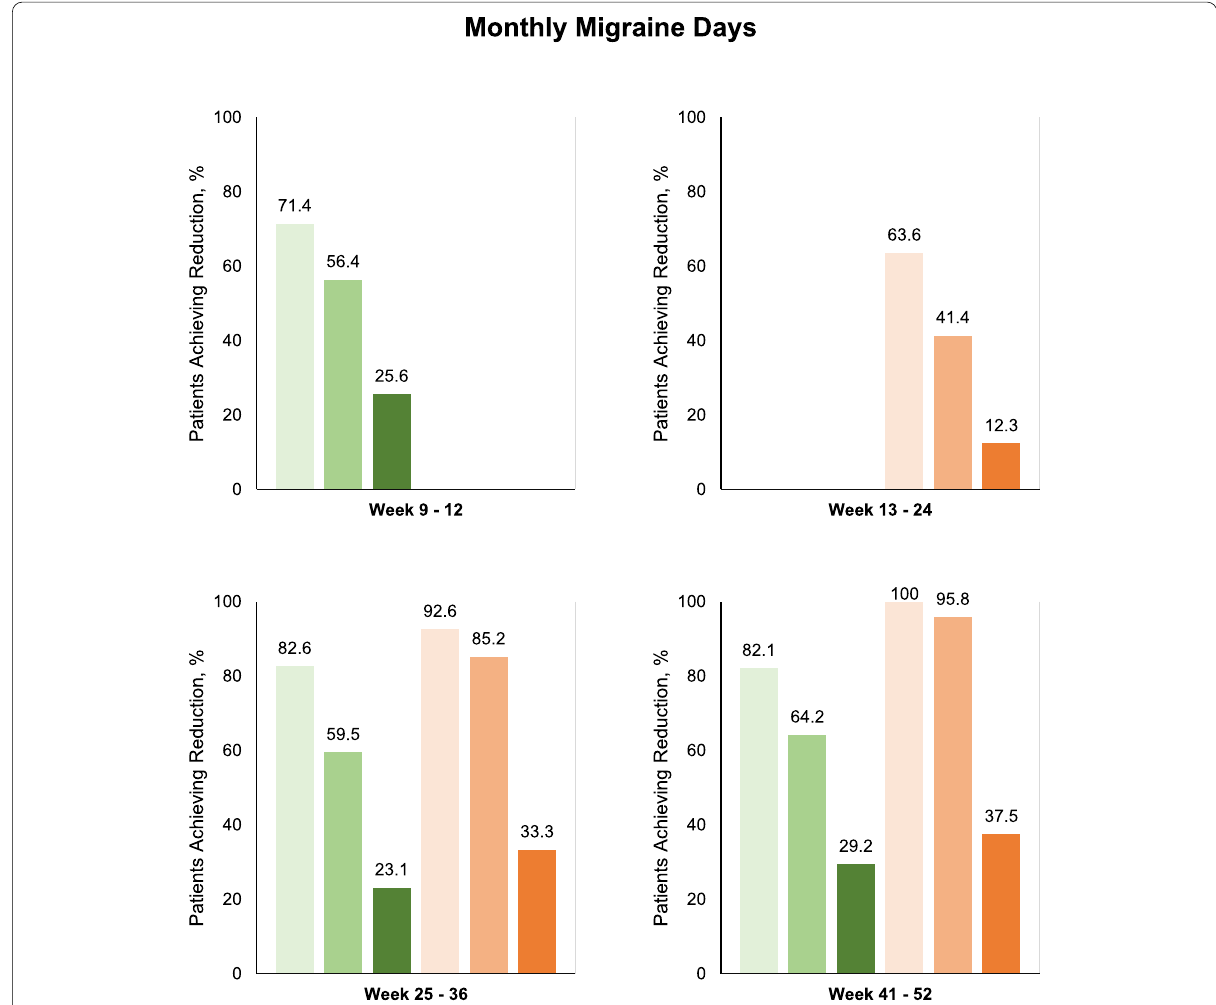
Fig. 2 Proportion of patients with 30%, 50%, and 75% reduction in number of monthly migraine days. Green represents patients treated ≥ ≥ ≥ with 140‑mg erenumab, light: 30%, medium: 50%, and dark: 75%. Orange represents patients treated with 70‑mg erenumab, light: ≥ ≥ ≥ medium: 50%, and dark: 75%. Participants with data available for analysis; Weeks 9–12, n ≥ ≥ n 121; 70‑mg, n 27; Weeks 41–52; 140‑mg, n 95; 70‑mg, n = = = =